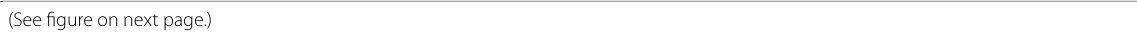
Fig. 9 Detection of apoptosis by TUNEL. A Cells with TUNEL and DAPI staining; B apoptosis rate. Data are the mean ### P < 0.005 vs. LPS; && P < 0.01 vs. LPS +